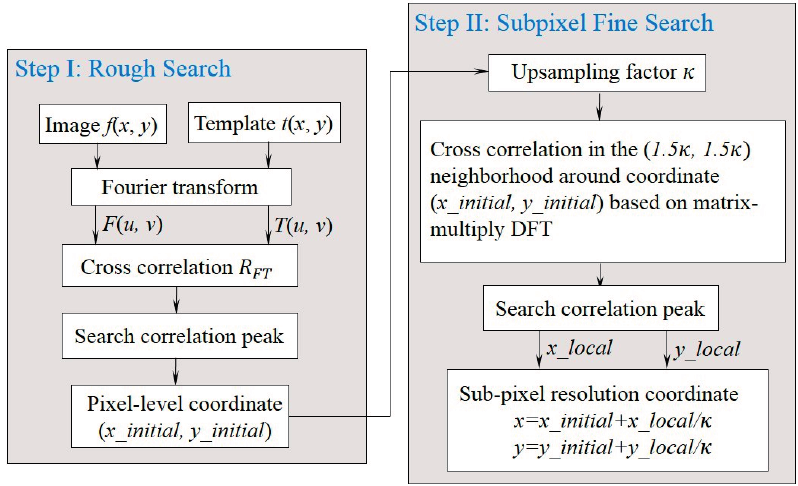
Figure 4. Flowchart of the upsampled cross correlation (UCC)